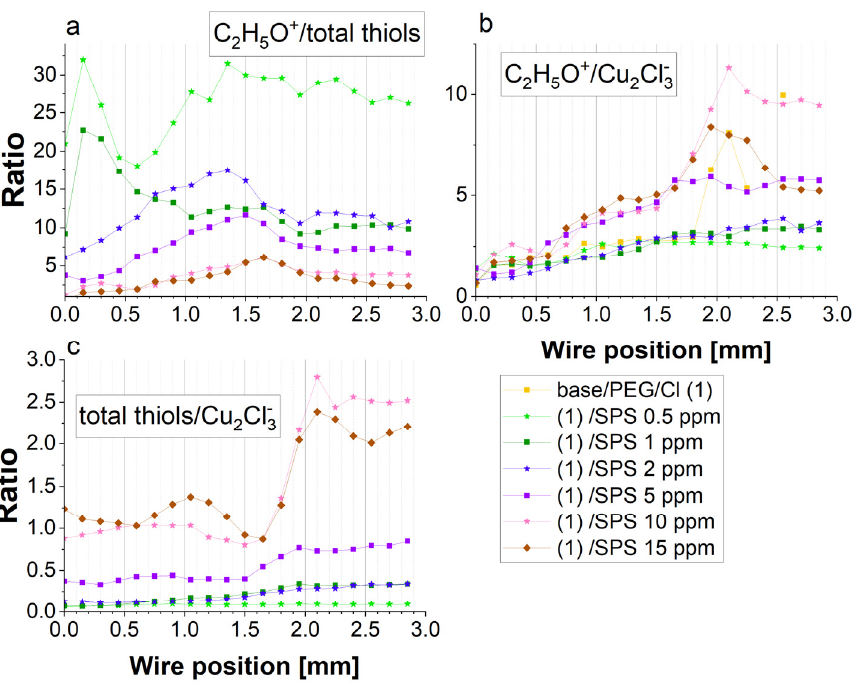
Figure 7. Distribution of the ratio of C 2 H 5 O + /total thiols ( a ), C 2 H 5 O − /Cu 2 Cl 3 − ( b ), and total thi- ols/Cu 2 Cl 3 − ( c ) as a function of the wire position for the base solution, base/PEG, base/PEG/Cl, and base/PEG/SPS at concentrations of 0.5, 1, 2, 5, 10, and 15 ppm.